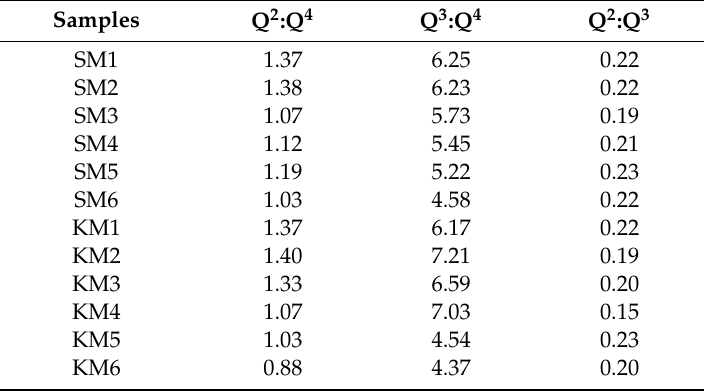
Table 6. Peak ratios of 1 H decoupled 29 Si solid-state MAS NMR spectra of SBA-15 and KIT-6 samples. Samples Q 2 :Q